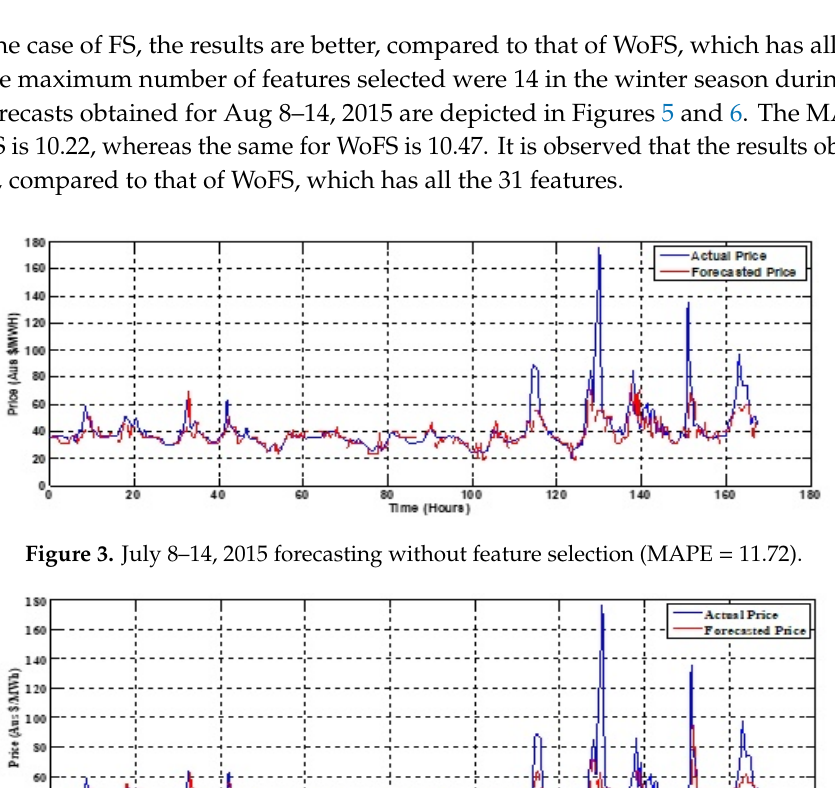
Figure 4. July 8–14, 2015 forecasting while, minimum number of features selected in the winter season (MAPE = 9.38).